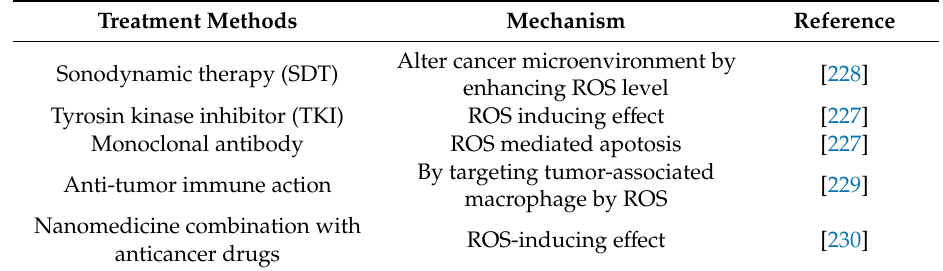
List of other treatment methods used in cancer treatment via reactive oxygen species-based